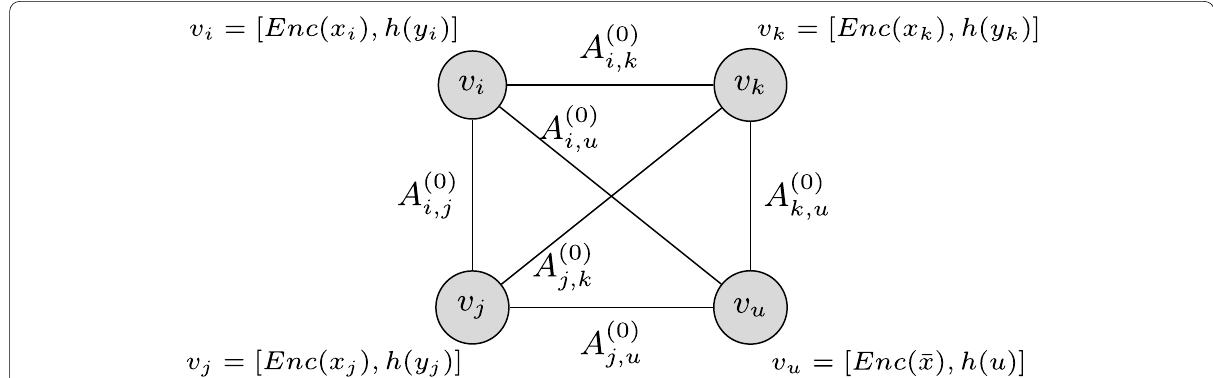
Fig. 6 Illustration of the input of the first layer (here a graph convolution) of a GNN. Here, we have three samples (represented by vertices v i , v j and v k ) in the support set and one query (represented by the vertex v u